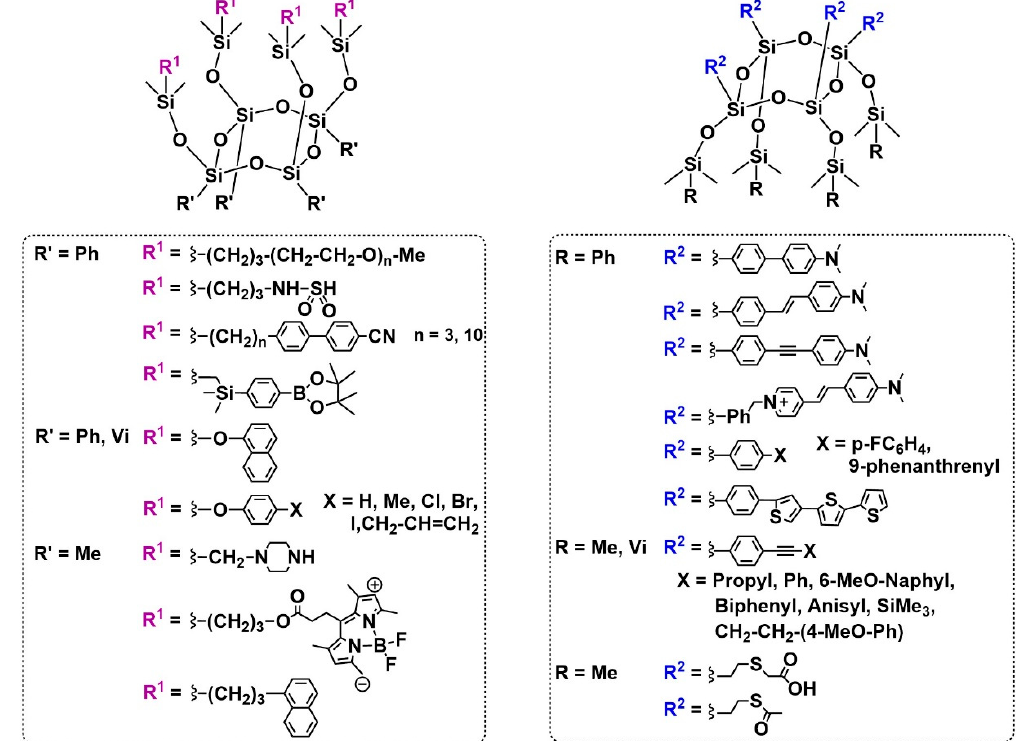
Figure 2. Existing functional Janus tetrapod silsesquioxanes [11,23,24,37–51] .